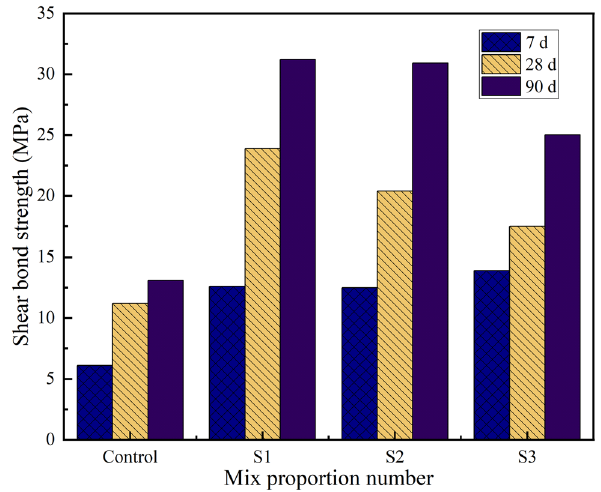
Figure 15: Shear bond strength of geopolymer with or without nano - SiO 2 [ 41 ]